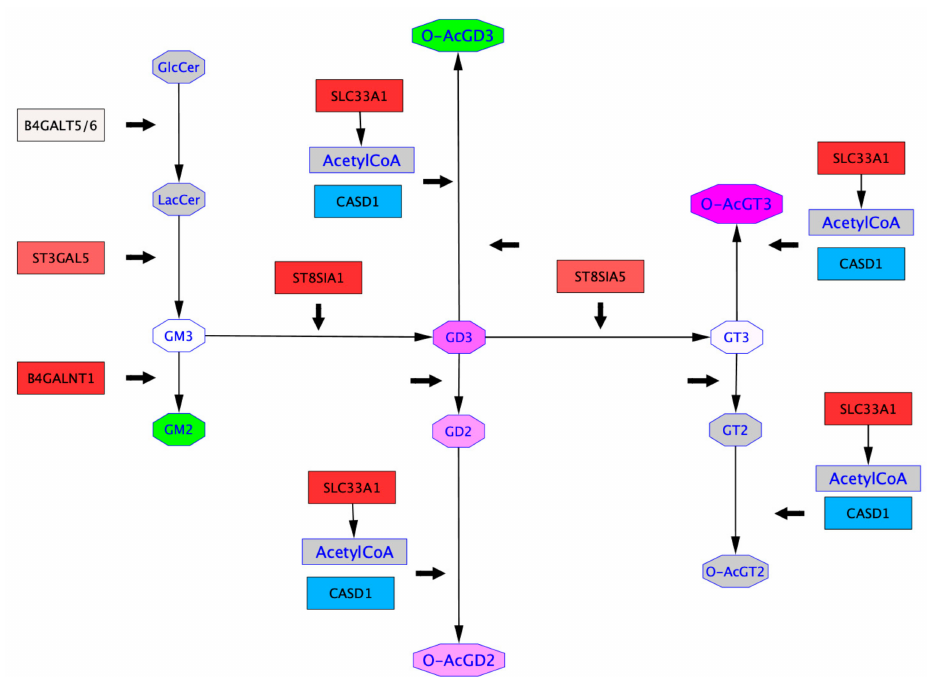
Figure 6. Di ff erential ganglioside metabolism pathways between Hs 578T and MDA-MB-231 breast cancer cells. Glycosyltransferase gene expression profile obtained by qPCR were mapped onto a subpart of the “Ganglio-sphingolipid metabolism” pathway from WikiPathways [18,19] based on the di ff erential expression between two cell lines. In the squared nodes, colors vary from blue ( ≤ − 2) to white ( = 0) and red ( ≥ 2) to indicate the repression to the over-expression of the glycosyltransferase gene in Hs 578T compared to MDA-MB-231 cells (thick black arrows). Quantitative data concerning the relative amounts of gangliosides obtained by MALDI-QIT-TOF mass spectrometry were added to the pathway based on the comparison between Hs 578T and MDA-MB-231 cells. In the octagonal nodes, colors vary from green ( ≤ − 8) to white ( = 0) and fuchsia ( ≥ 8) to indicate a restraint to a rise of the amount of a given ganglioside based on the di ff erences observed between the two cell lines. Grey color indicates the absence of any available quantitative data about the